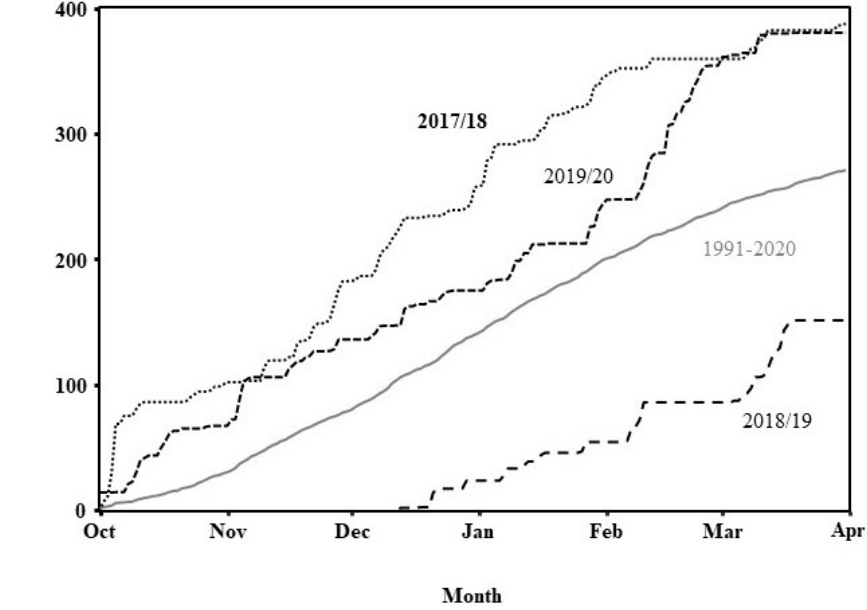
Figure 1. Accumulated percolating water (mm per m 2 ) over the three winter leachate periods